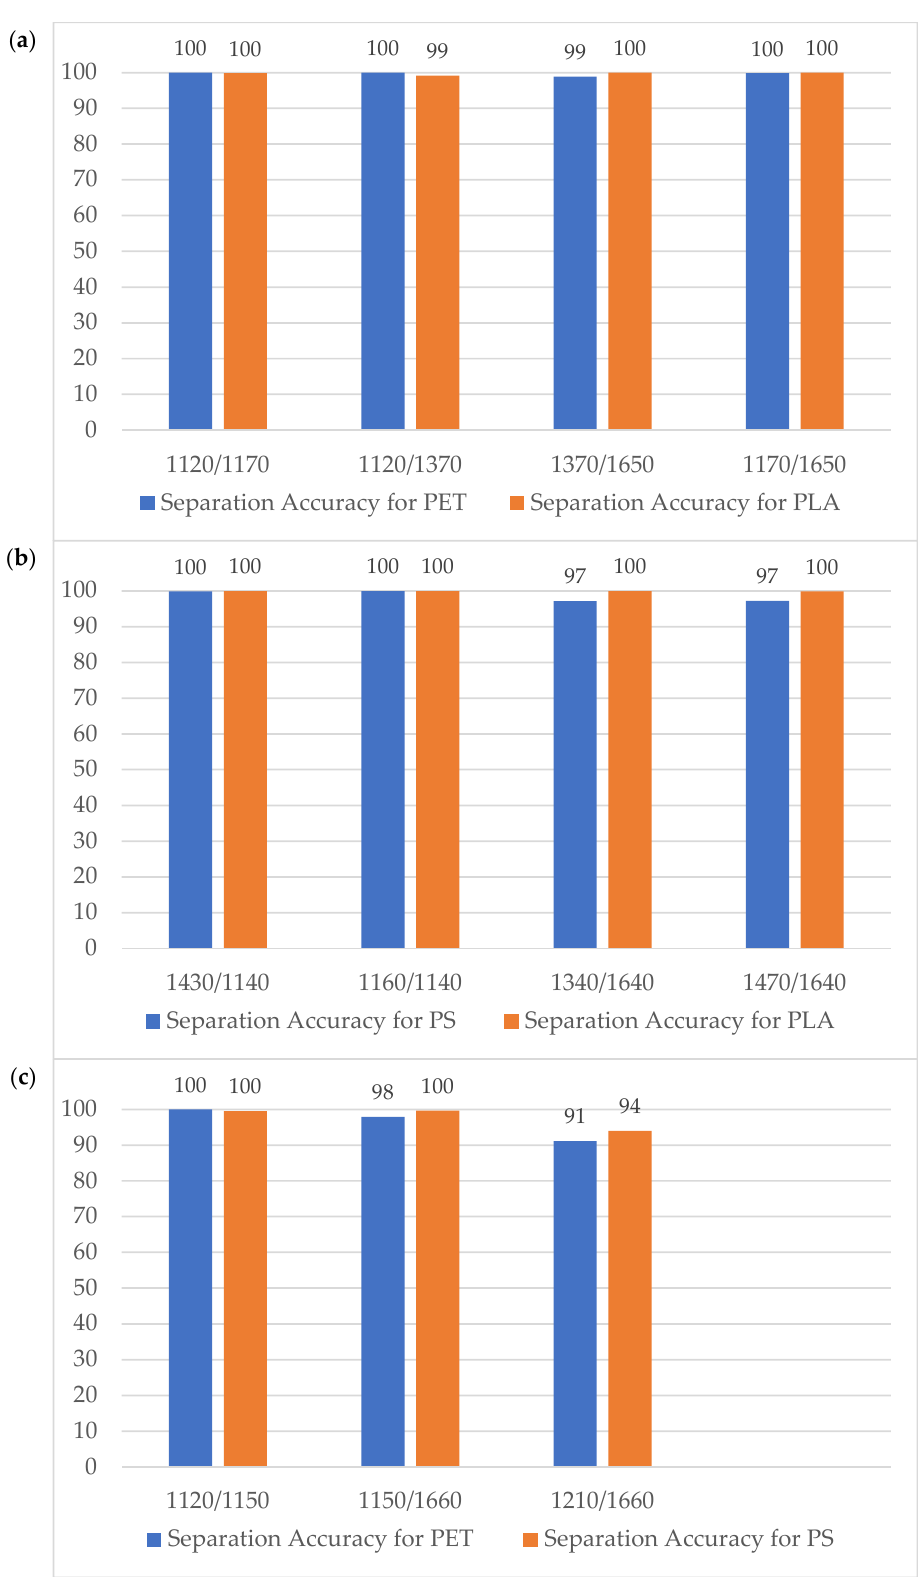
Figure 10. Accuracy assessment of spectral indices computed employing the reflectance values after the continuum removal procedure was applied for pairs ( a ) PET-PLA; ( b ) PS-PLA; ( c ) PET-PS.